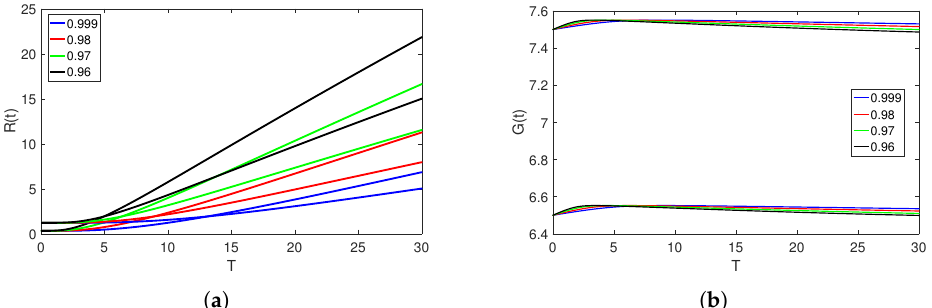
Figure 12. Dynamical behavior of the recovered class ( a ) and isolated class ( b ) on different arbitrary fractional order ς on sub interval [ 0, t 1 ] and [ t 1 , T ] of [ 0, T ] , for different initial